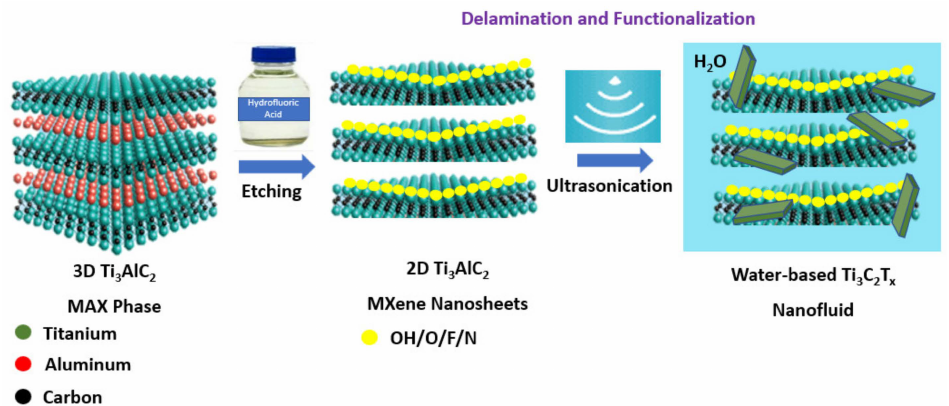
Schematic diagram of the synthesis procedure of MXene nanosheets in a water- based